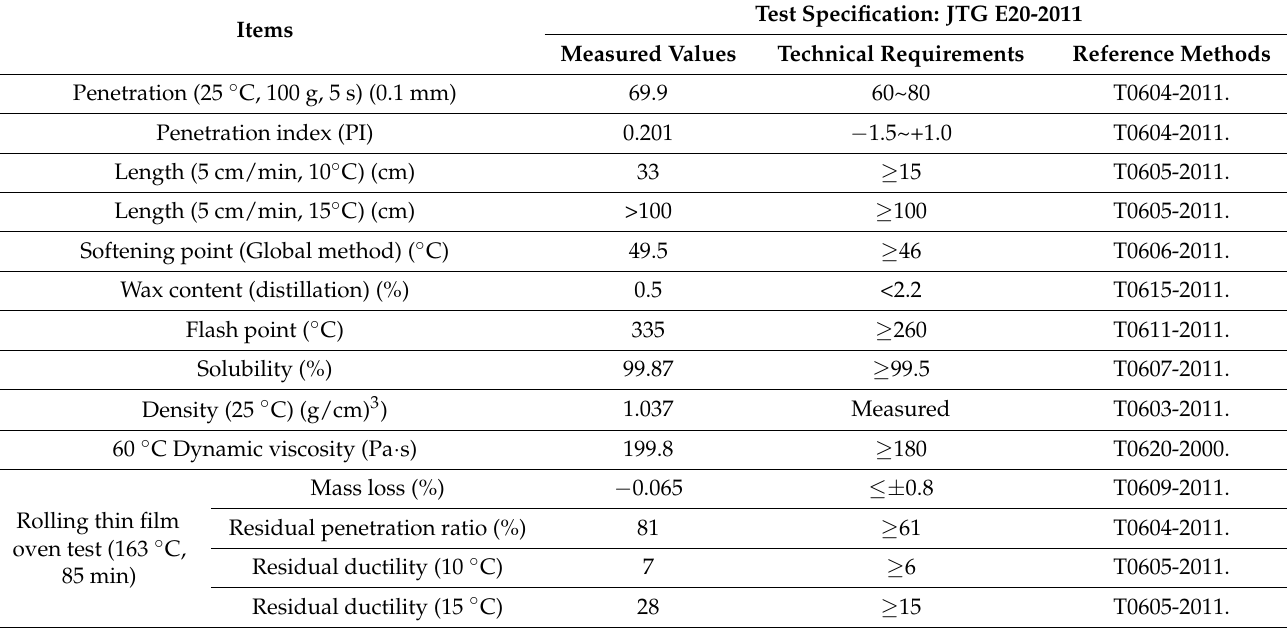
Table 2. Test results of A-70 # neat